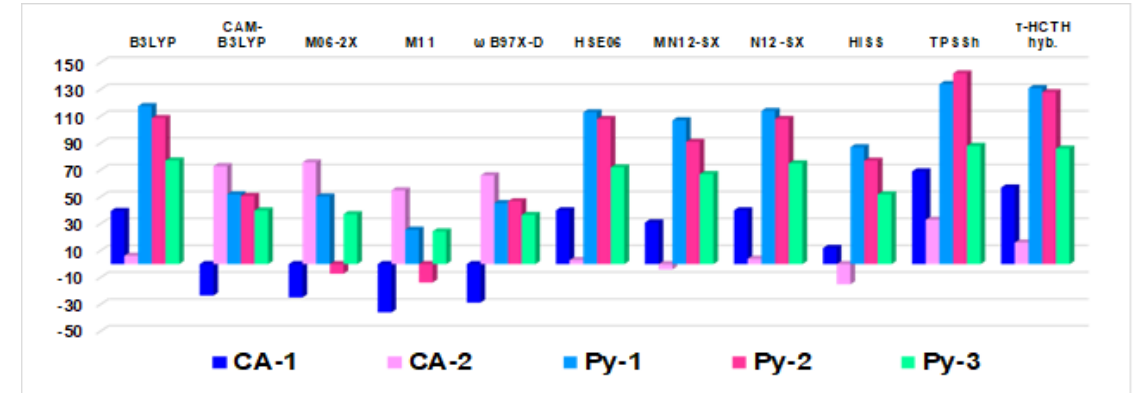
Figure 1 . Mean signed deviation (nm) of calculated λmax to experimental λmax. Figure 1. Mean signed deviation (nm) of calculated λ